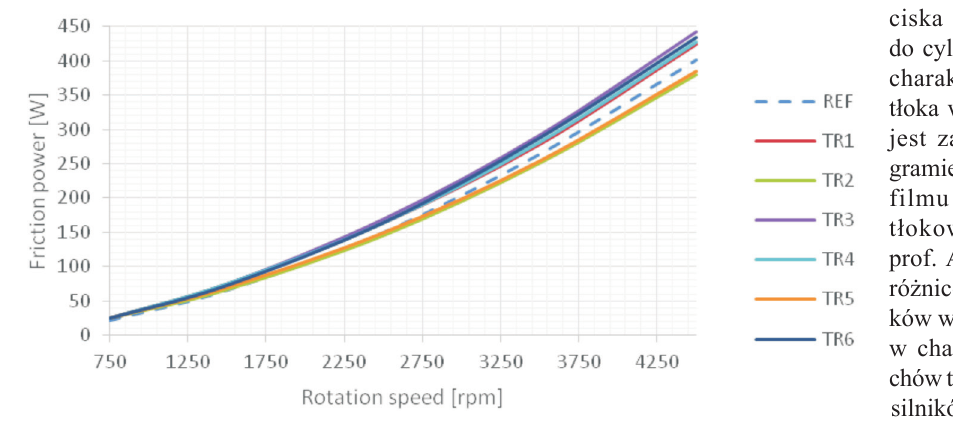
Fig. 5. Simulation results for the SI engine